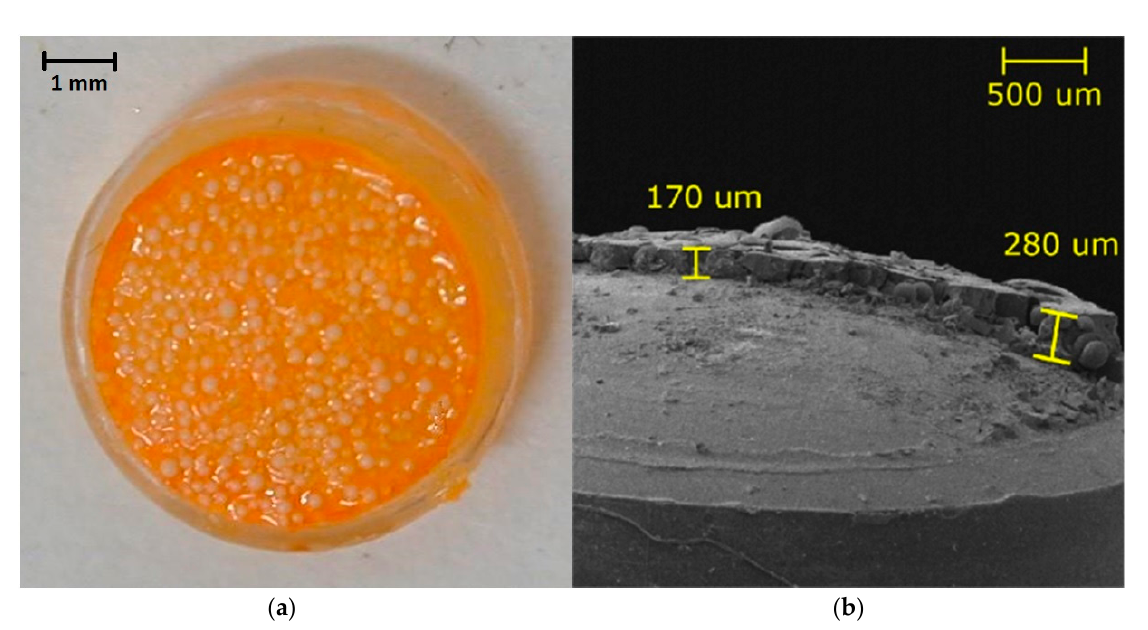
A schema with photos of the feedback regulation system is on Figure 2.